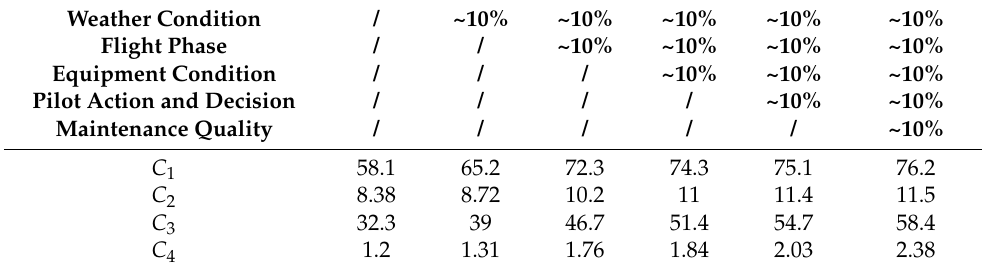
Table 7. Casualty rate of minor change in variables.